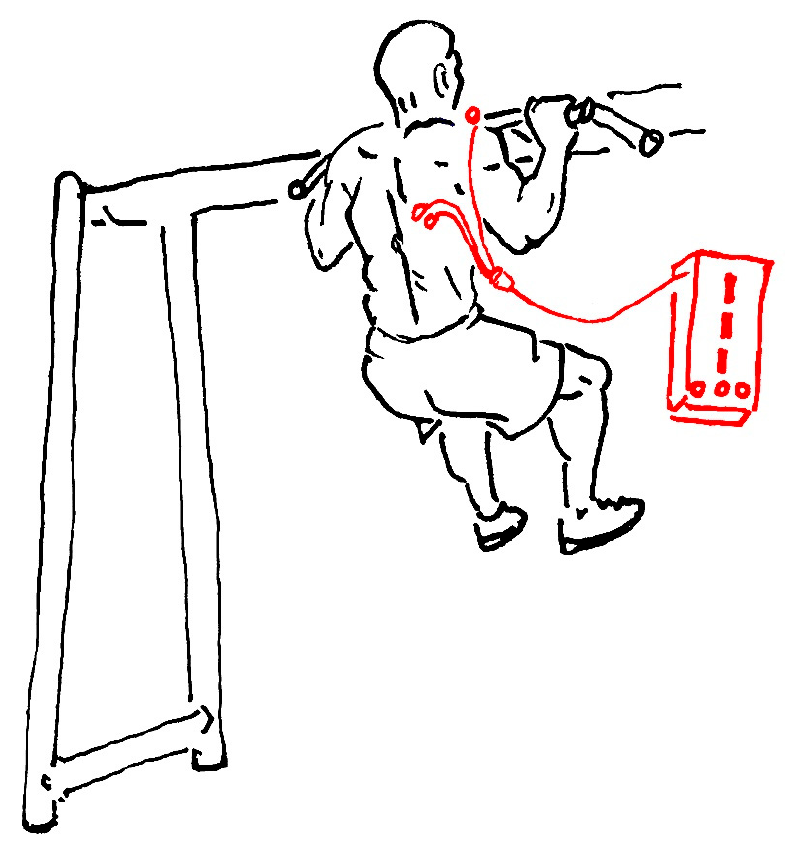
Figure 1. The static pose of the latissimus dorsi muscle test. The red dots show the placement positions and sites of sEMG electrodes.